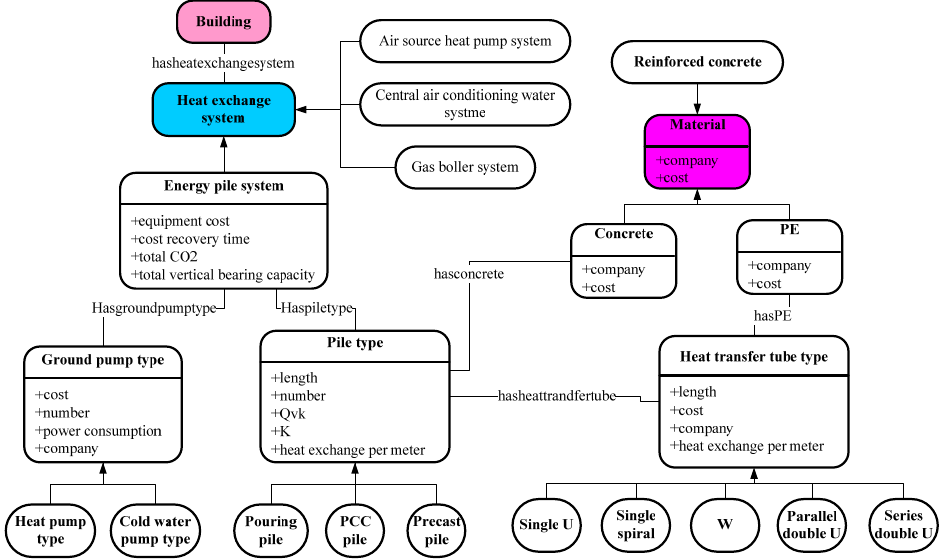
Figure 3. Flow diagram of UML classes for the core concepts of OntoEPS.